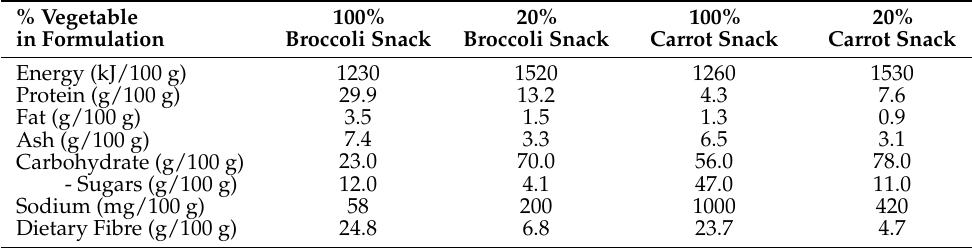
100% Broccoli Snack